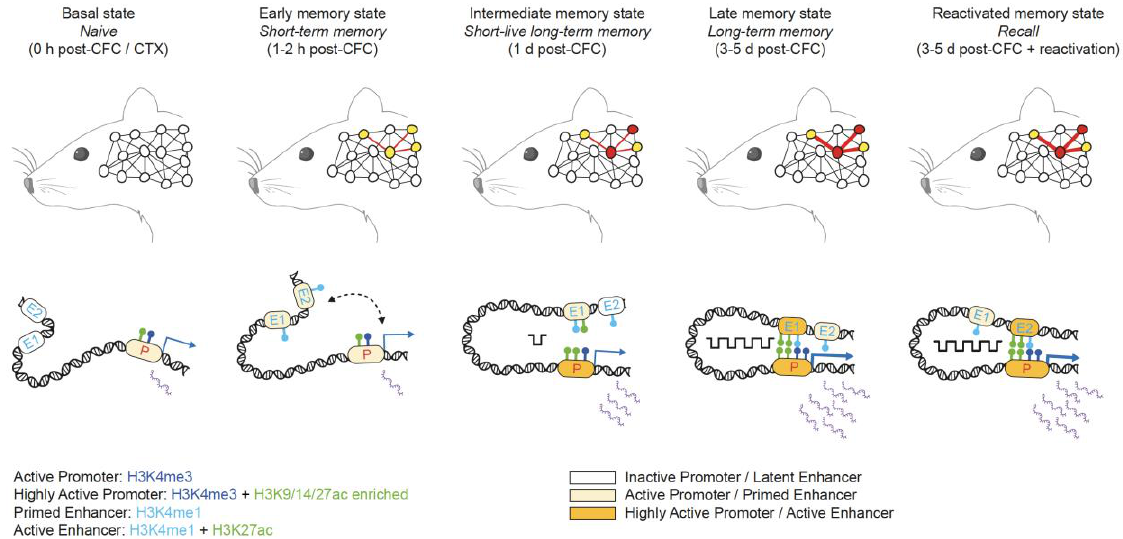
Figure 3. Proposed model of how temporal and spatial changes in the epigenome and the 3D chromatin architecture regulate the transcription of PRGs critical for neuroplasticity and memory. The epigenetic status of PRG promoters and enhancers along with the formation EPIs by chromatin looping are depicted across sequential stages of fear memory ensemble in hippocampal engram neurons. In the naive animal condition (i.e., basal state), basal gene expression of PRGs such as PSD-95 is mediated by a limited activation of the promoter (P) (enrichment in H3K4me3 and limited enrichment of H3K27ac, H3K9ac and H3K14ac). During short-term memory (i.e., early memory state), enhancers (E) are primed (H3K4me1), to subsequently interact through DNA looping with their target promoters. During short-lived long-term memory (i.e., intermediate memory state) — as a result of the activation of the NMDAR-ERK-CREB-signaling pathway that mediates P300/CBP recruitment (see Figure 2) — H3K27ac becomes significantly enriched, leading to both enhancer activation (H3K4me1+H3K27ac) and increased promoter activity. Hence, there is an initial establishment of low-frequency EPIs, paralleled by an increased transcription of the PRG (depicted under the PSD-95 gene). High-promoter and enhancer activation (reflected by high enrichment of the H3K27ac mark) during long-term memory (i.e., late-memory state) accompanies robust expression of the PRG. During recall, the delayed transcription surge of PRGs is principally mediated by a de novo EPI (depicted as enhancer 2, E2).